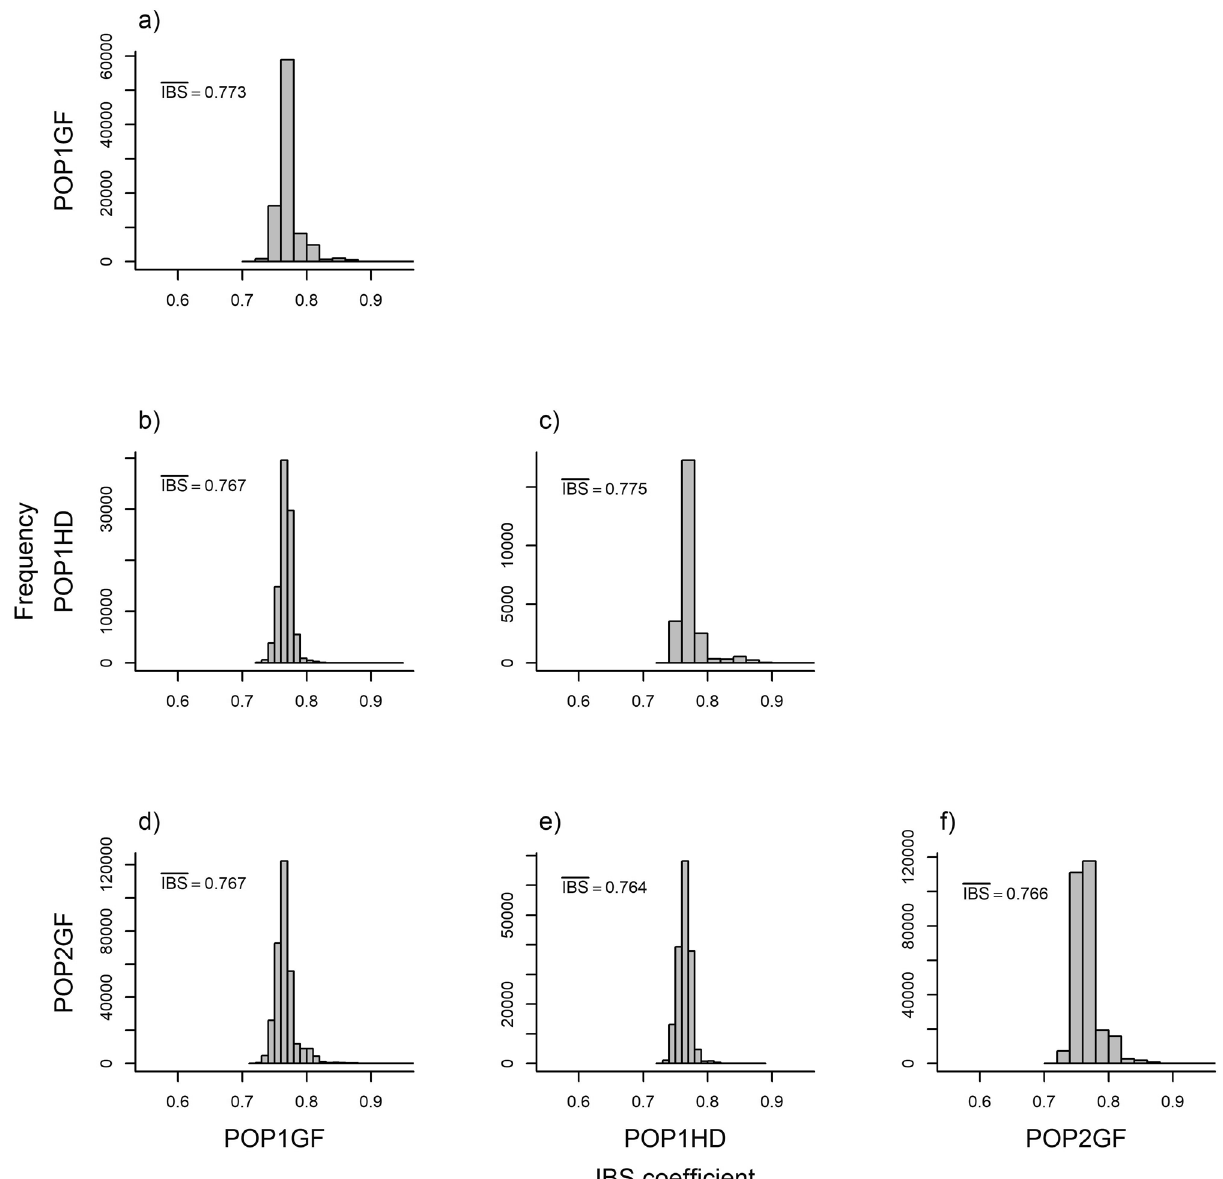
Figure 4. Distribution of identity by state (IBS) coefficients: ( a ) within POP1GF population; ( b ) between POP1GF and POP1HD population; ( c ) within POP1HD population; ( d ) between POP1GF and POP2GF population; ( e ) between POP1HD and POP2GF population and ( f ) within POP2GF